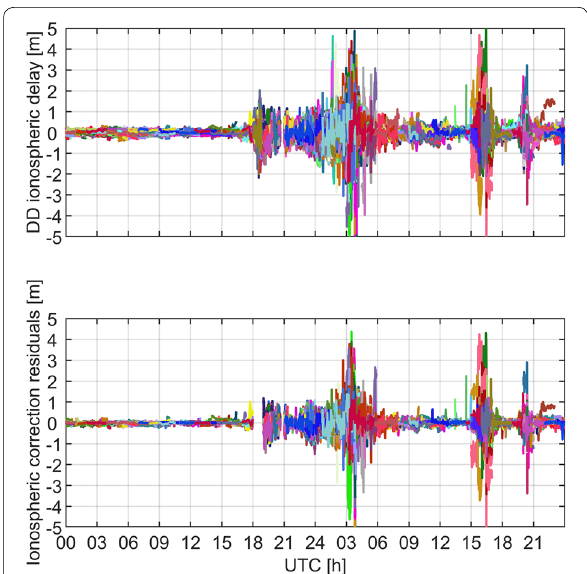
Fig. 7 Double-differenced ionospheric delays (top panel) and ionospheric correction residuals (bottom panel) for rover solution